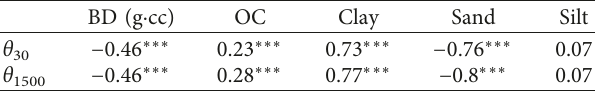
Table 3: Pearson correlation coefficients for soil